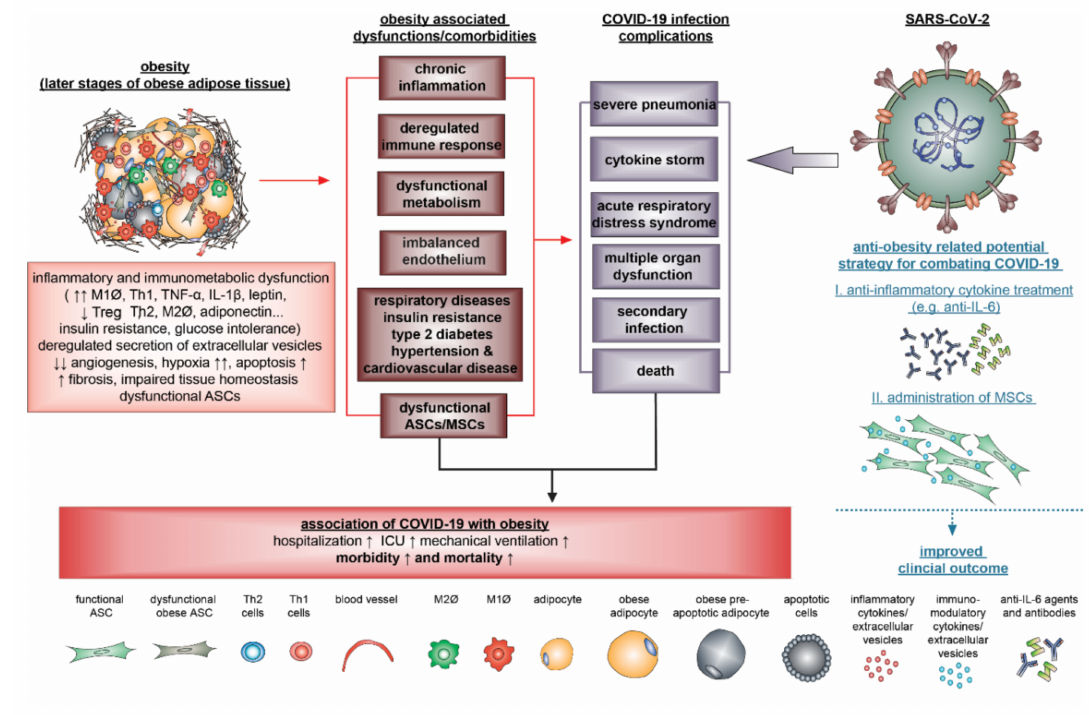
Figure 3. Schematic illustration presenting that obesity negatively impacts the development of COVID-19. Obesity is characterized by various pathological features, including systemic chronic inflammation, deregulated immune response, dysfunctional endothelium, increased comorbidities, and dysfunctional ASCs / MSCs, which fundamentally influence the progression and outcome of COVID-19. Anti-inflammatory cytokine therapies for example anti-IL-6 and administration of MSCs may be useful for supportively treating